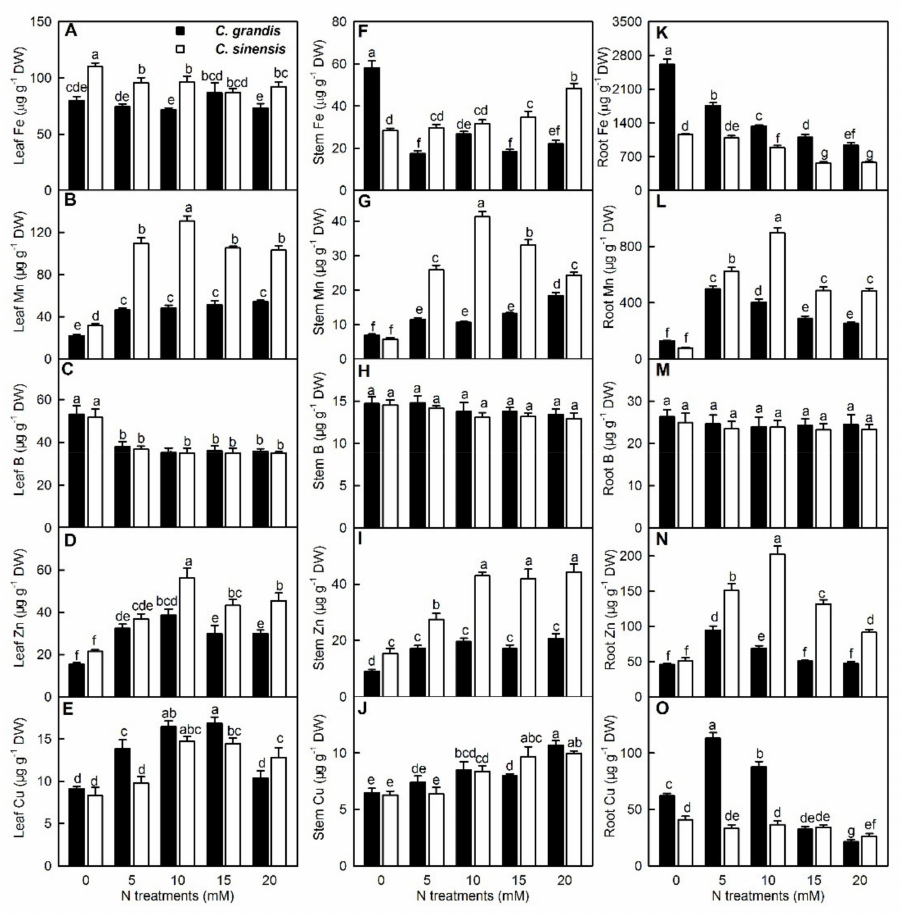
Figure 3. Effects of N supply on mean ( ± SE, n = 4) concentrations of Fe, Mn, B, Zn and Cu in leaves ( A – E ), stems ( F – J ) and roots ( K – O